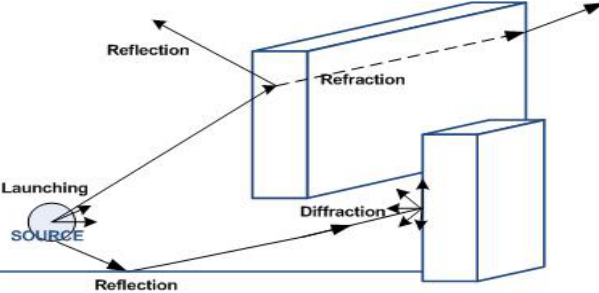
Figure 3. Principle of operation of the 3D ray launching method implemented in-house to perform indoor coverage